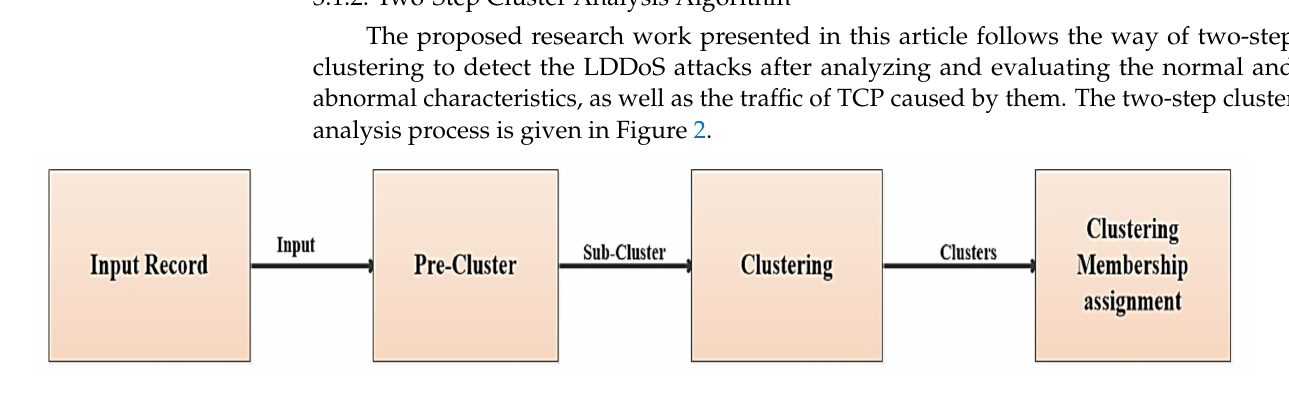
Figure 2. Flowchart of two-step cluster